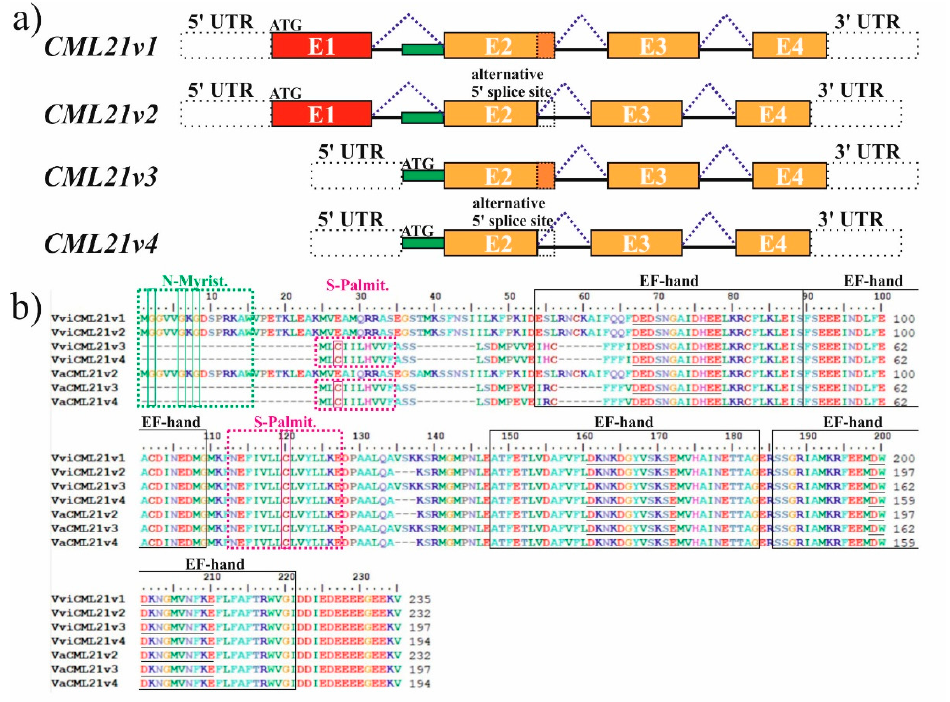
Figure 1. The structure representation and protein sequence analysis of CML21 mRNA splice variants in grapevine. ( a ) Alternatively spliced CML21 transcript variants of Vitis amurensis identified in this work VviCML21v2 , VviCML21v3 , VviCML21v4 ) predicted by genome sequence analysis and retrieved